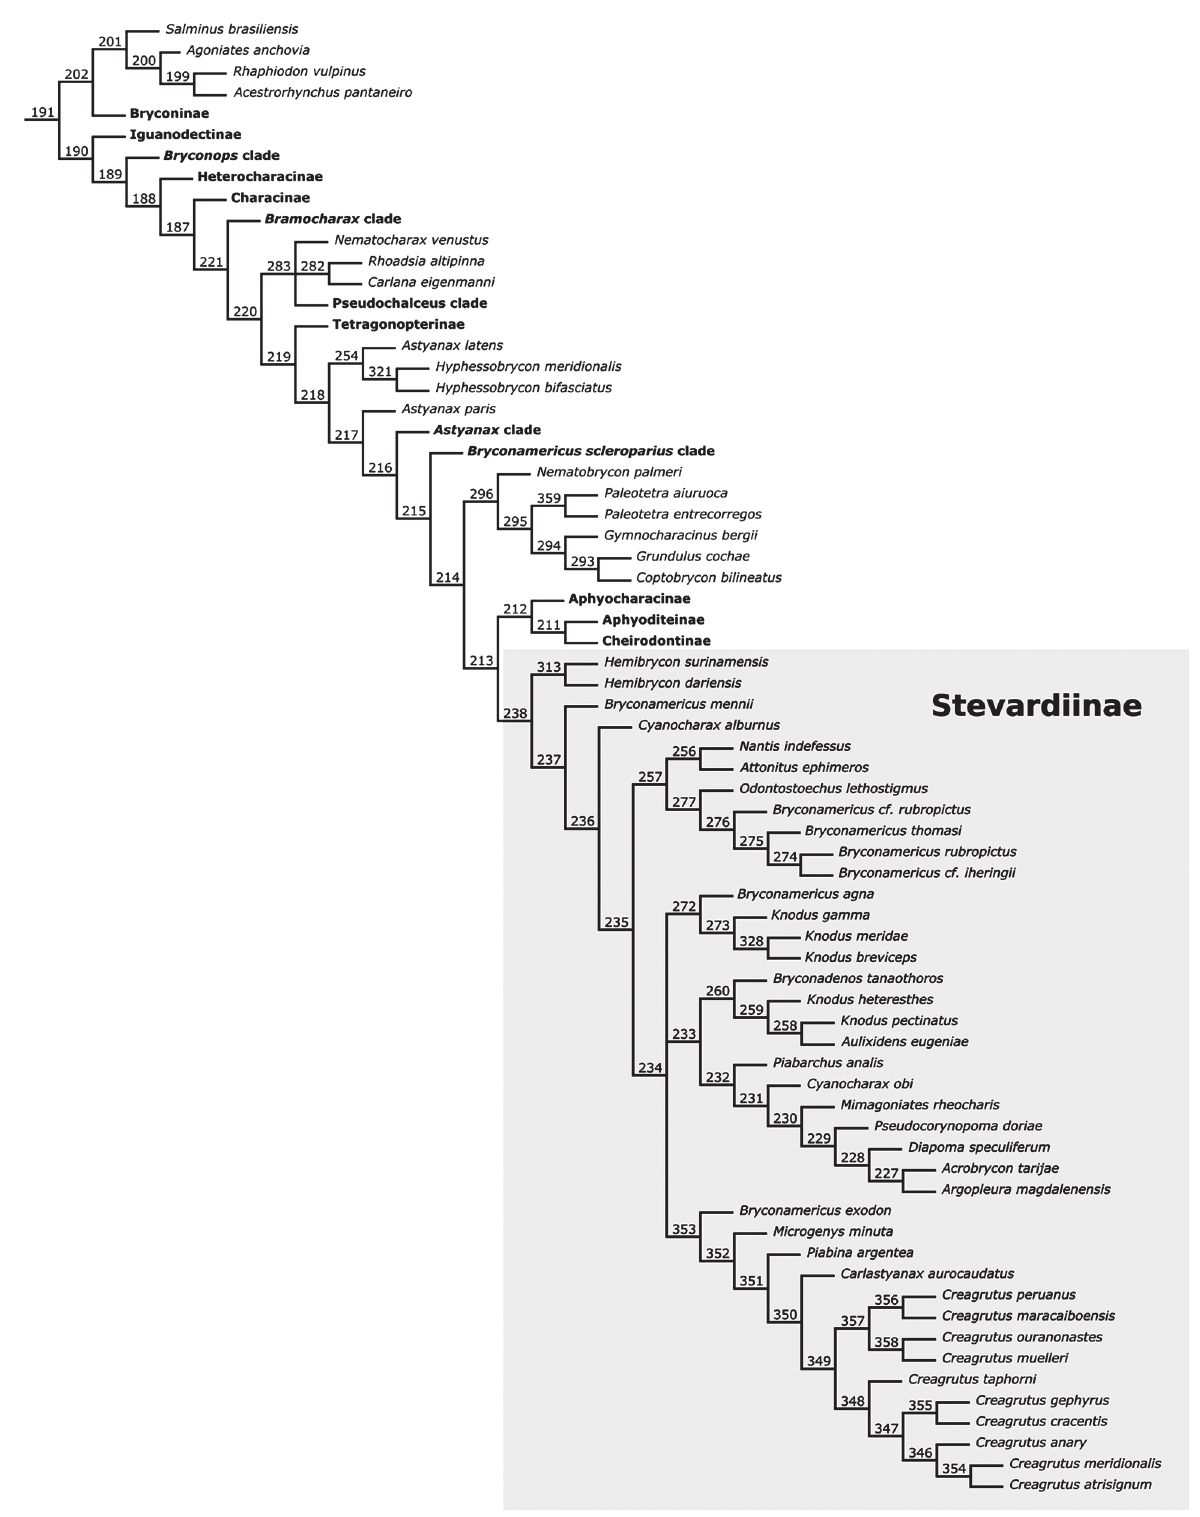
Fig. 7. Cladogram showing relationships of the Characidae obtained with the Examined Matrix. Node numbers correspond to those cited on the